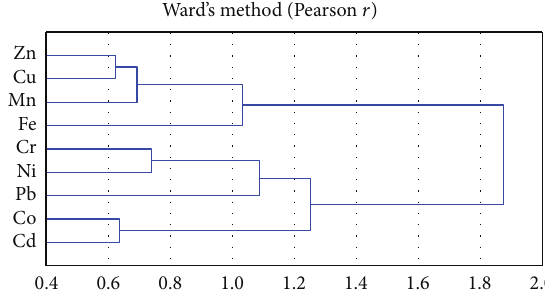
Figure3:DendrogramshowingclusteringoftracemetalsinMangla Lake.